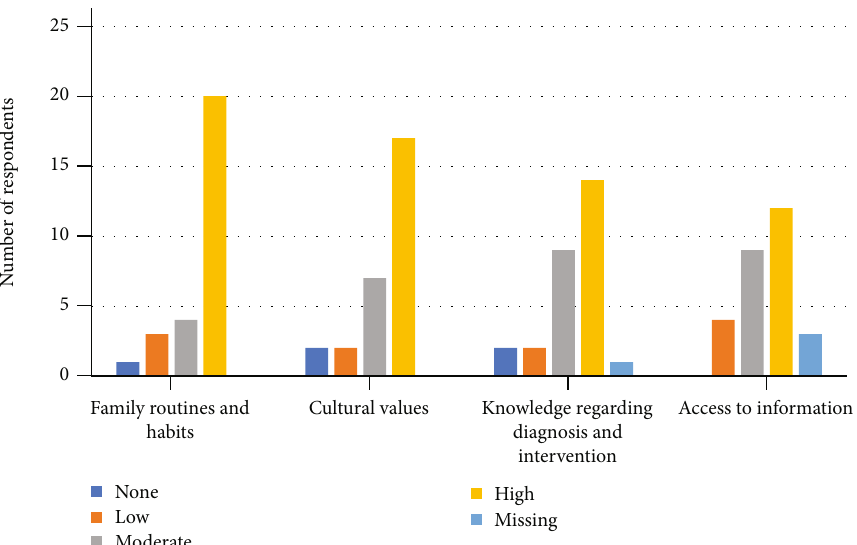
Figure 1: Features of the UO population that need to be addressed during the intervention process ( N = 28 ).